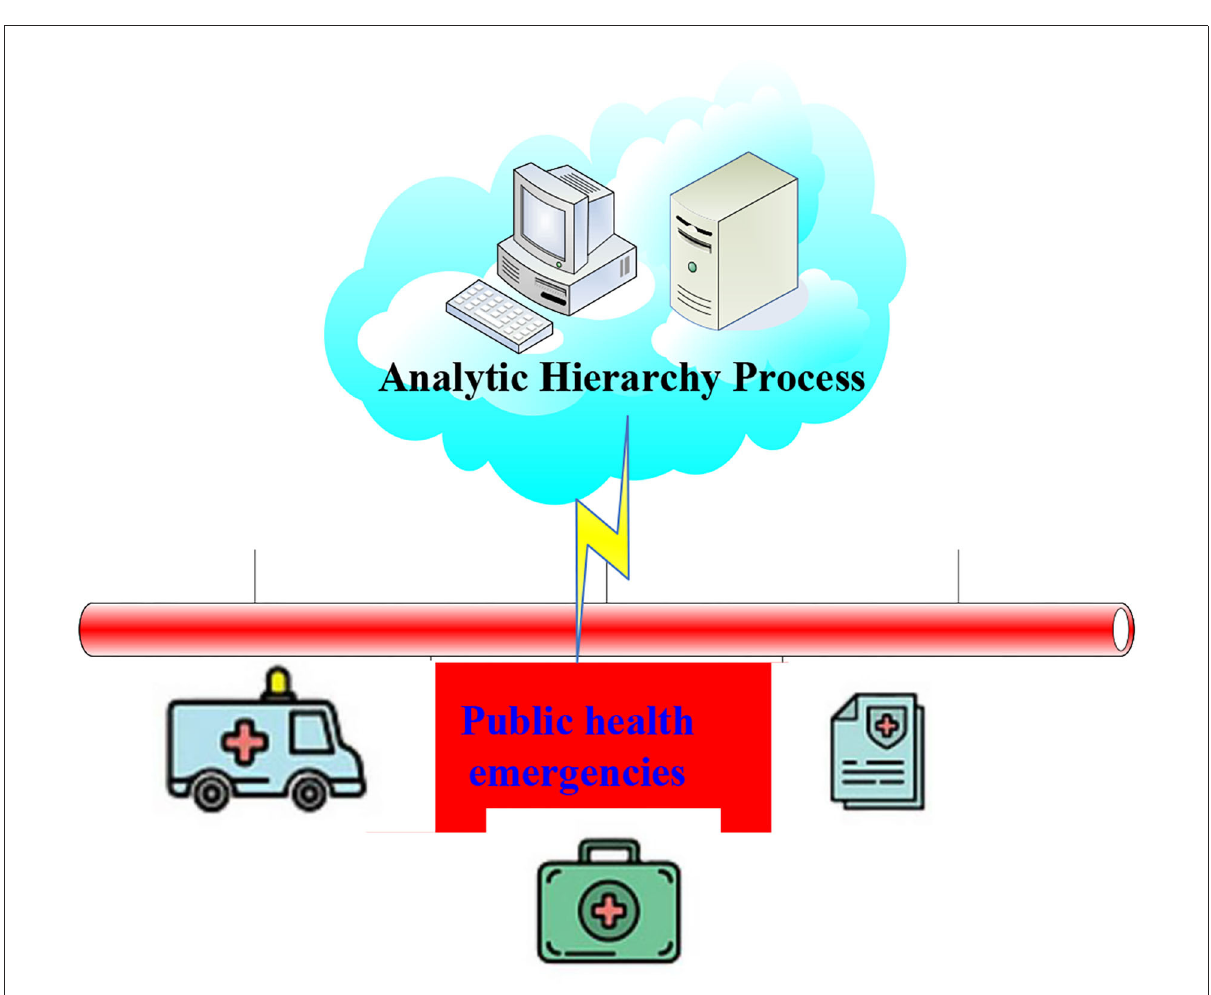
FIGURE2 Application of analytic hierarchy process in public health